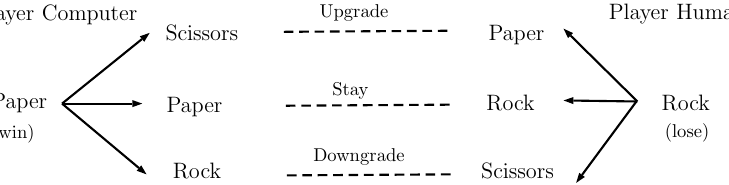
Figure 7. The example of change/stay strategy of Player Human against Player Computer that has a preferable change/stay action: if the Player Computer uses a “win-stay” pattern, then the best action for Player Human is “lose-downgrade”.